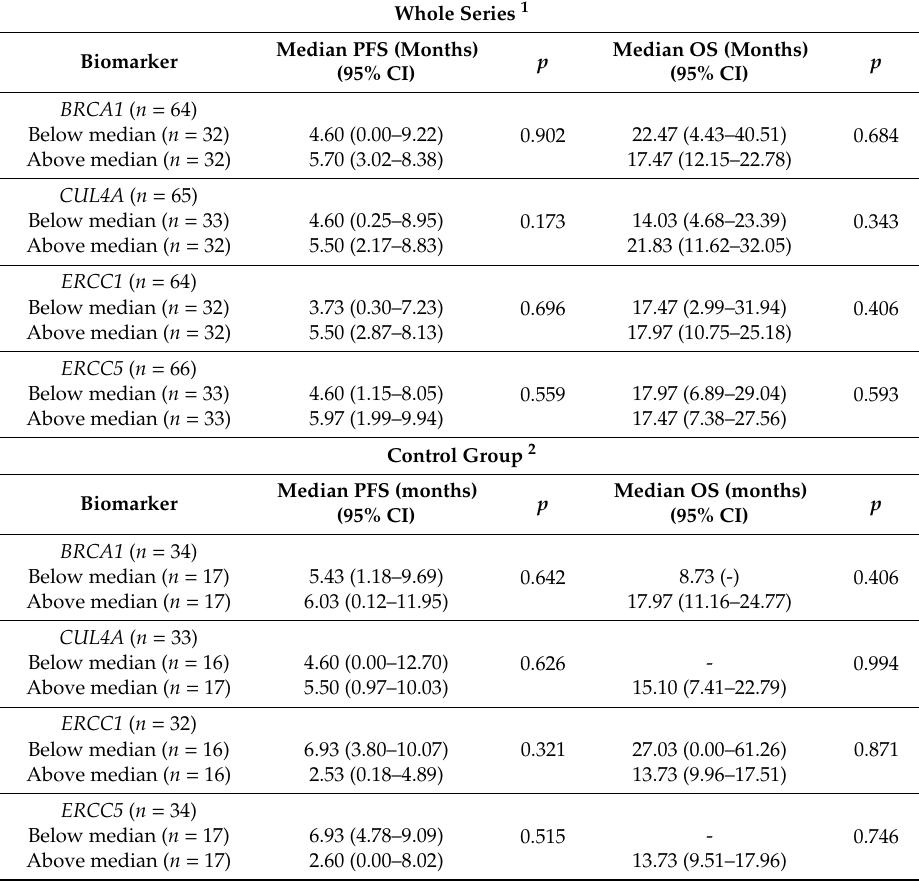
Table 3. Survival analysis in accordance to gene